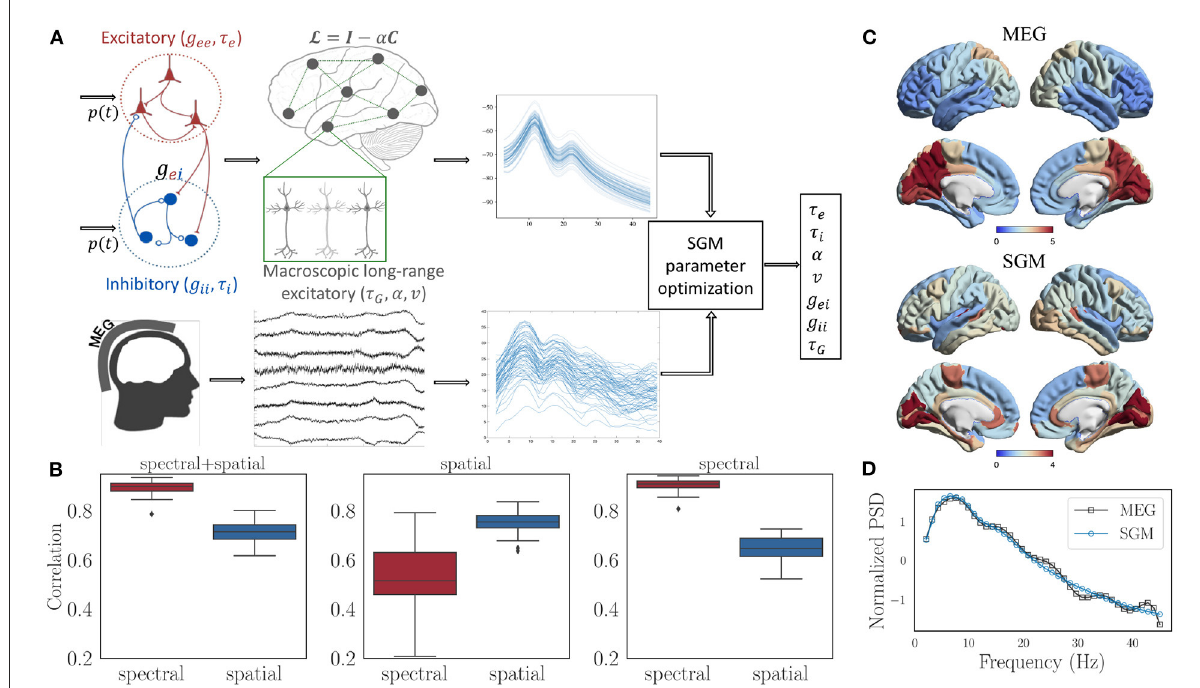
FIGURE2 (A) Flow chart showing the structure of SGM and inference of SGM parameters by comparing modeled frequency spectra with the empirical frequency spectra captured by MEG. Input p ( t ) is white Gaussian noise and is the same for both excitatory as well as inhibitory signals. (B) Spectral and spatial correlations obtained after optimization for all the subjects with three different cost functions: (1) spectral + spatial correlation, 2) spatial correlation, 3) spectral correlation. (C) Comparison of the empirical and modeled spatial distribution of the alpha frequency band, averaged over all the subjects. (D) Comparison of empirical and modeled frequency spectra, averaged over all brain regions and